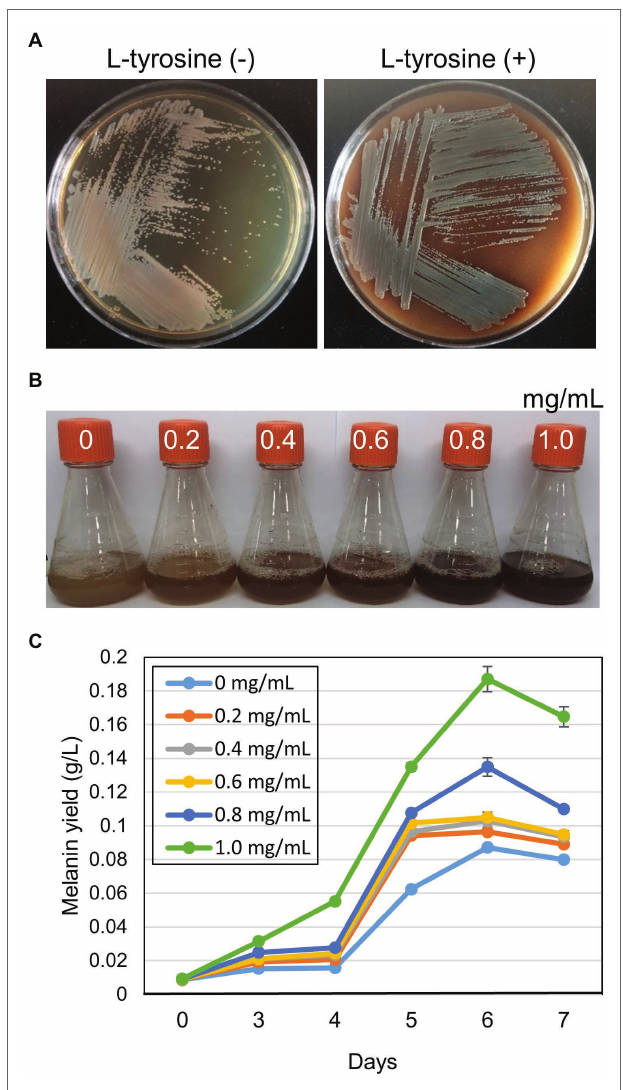
FIGURE 3 | Melanin-like pigment production of strain GR-TSA-9 T on tryptic soy agar (TSA) medium. (A) Melanin-like pigment production of strain GR- TSA-9 T on TSA without and with L-tyrosine participation; dark brown pigment was produced on the L-tyrosine medium for 5 days. (B,C) Effect of L-tyrosine concentration on melanin production in TSB medium. The graph represents the average of the results from three replicate